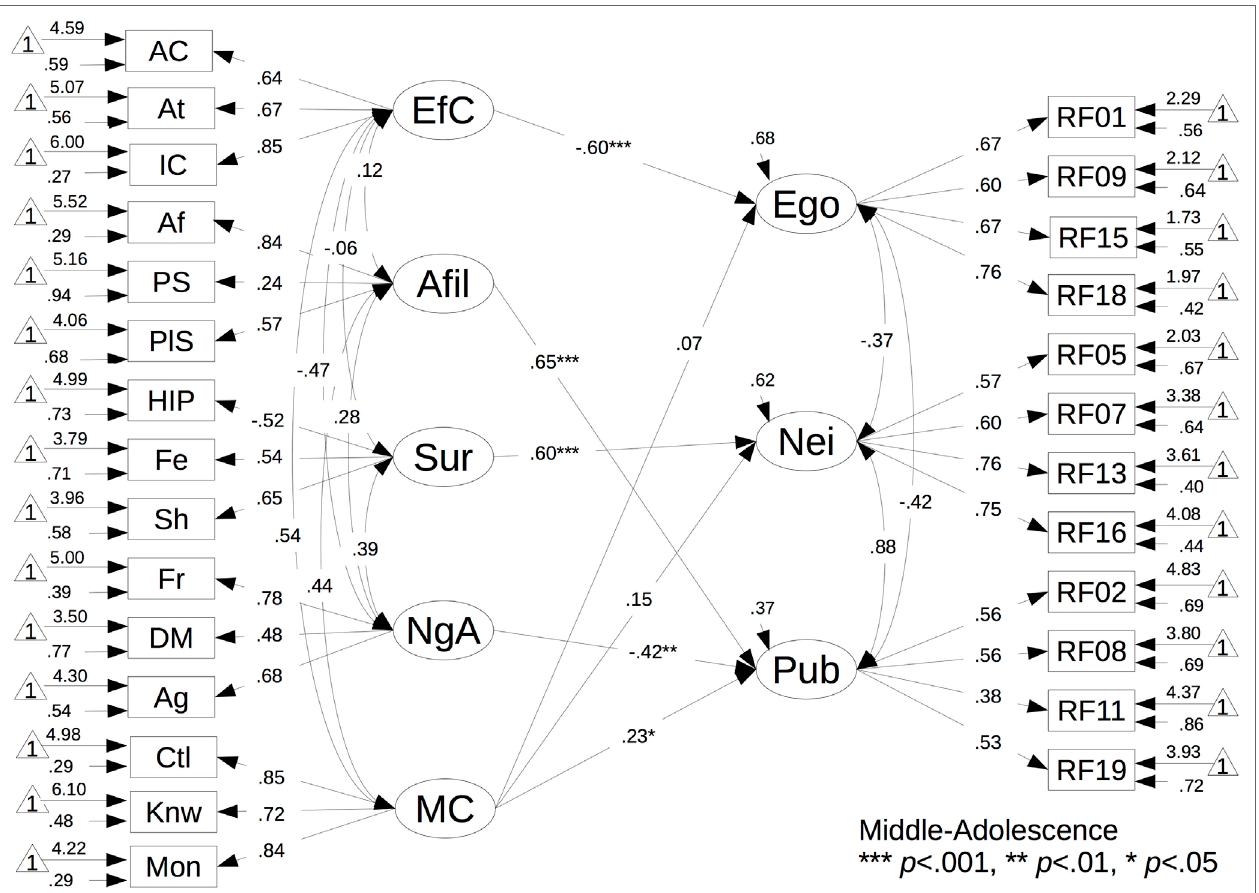
FigUre 3 | Path diagrams for middle-adolescence group for temperament, metacognition, and frames of reference in behaviors in public situations by multiple group structural equation modeling. EfC, effortful control; Afil, affiliativeness; Sur, surgency; NgA, negative affect; AC, activation control; At, attention; IC, inhibitory control; Af, affiliation; PS, perceptual sensitivity; PlS, pleasure sensitivity; HIP, high-intensity pleasure; Fe, fear; Sh, shyness; Fr, frustration; DM, depressive mood; Ag, aggression; MC, metacognitive awareness; Mon, monitoring; Ctl, control; Knw, metacognitive knowledge; Ego, egocentrism; Nei, neighborhood evaluation; Pub, public values. * p < 0.05, ** p < 0.01, *** p <